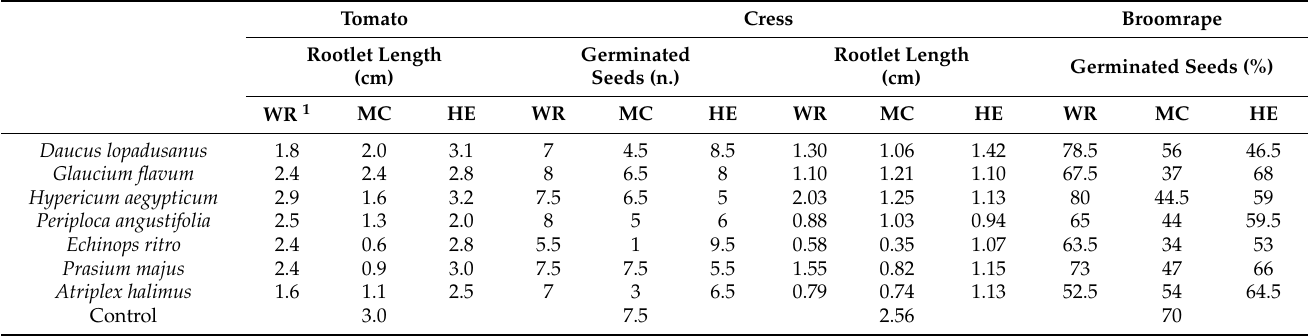
Table 2. Effect of the extracts in phytotoxicity assay.